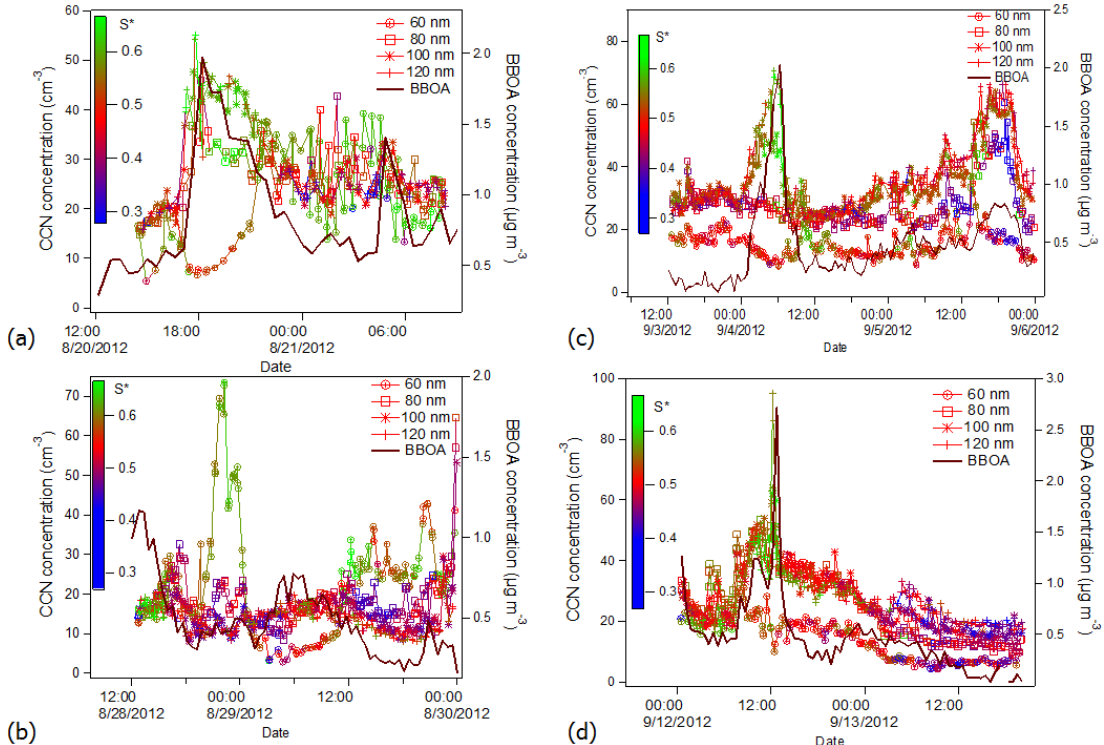
Figure 4. CCN concentrations for the selected particle sizes during the arrival of the smoke plumes for (a) Chios, (b) Croatia, (c) Euboea and (d) Andros. The black solid line represents the biomass-burning component of the organic aerosol at the given